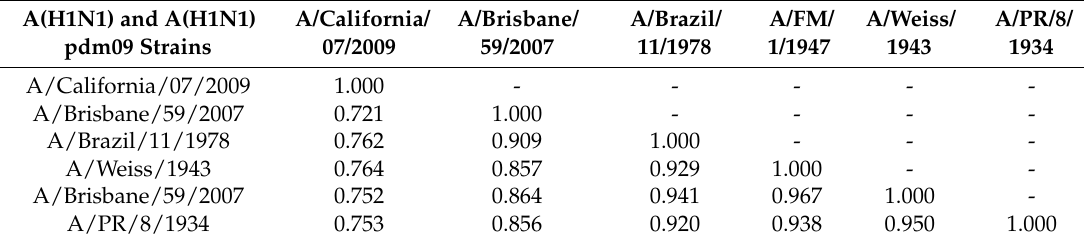
Table 4. Genetic similarity expressed as a percentage of similarity/100 of the NA1 subunit of the neuraminidase gene between the different influenza A(H1N1) and A(H1N1) pdm09 strains analyzed.